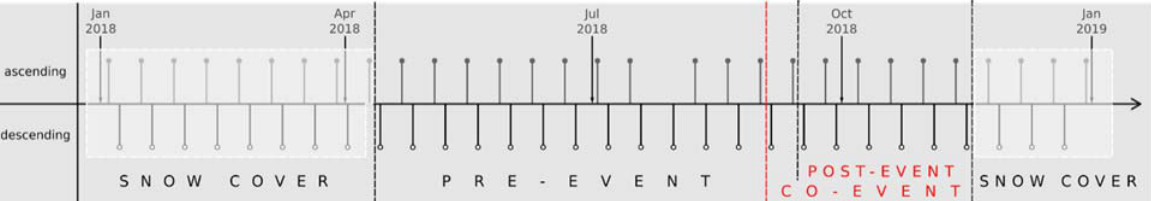
Figure 4. Temporal spacing of S1 acquisitions according to the geometries and the main landslide event (indicated by a red dashed line).